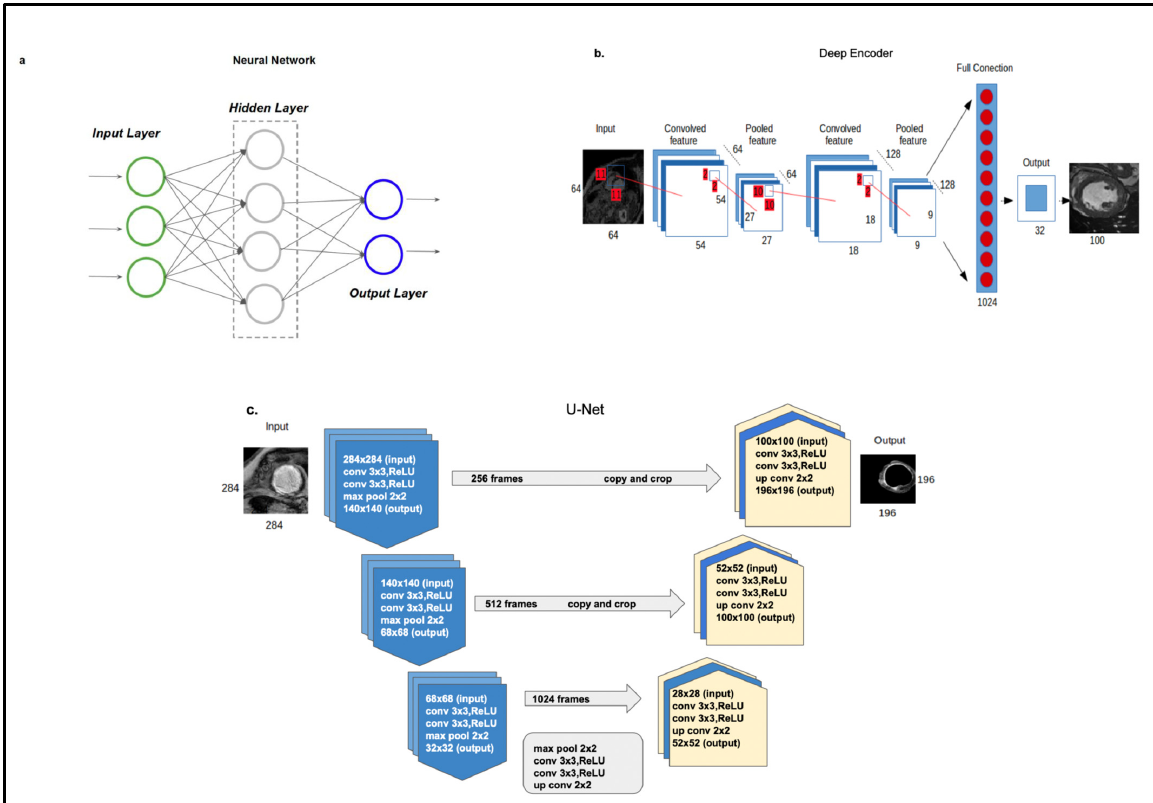
Figure 3. Left ventricular segmentation techniques used in CMR: ( a ). Neural network, ( b ). Deep encoder, ( c ). U-net architecture